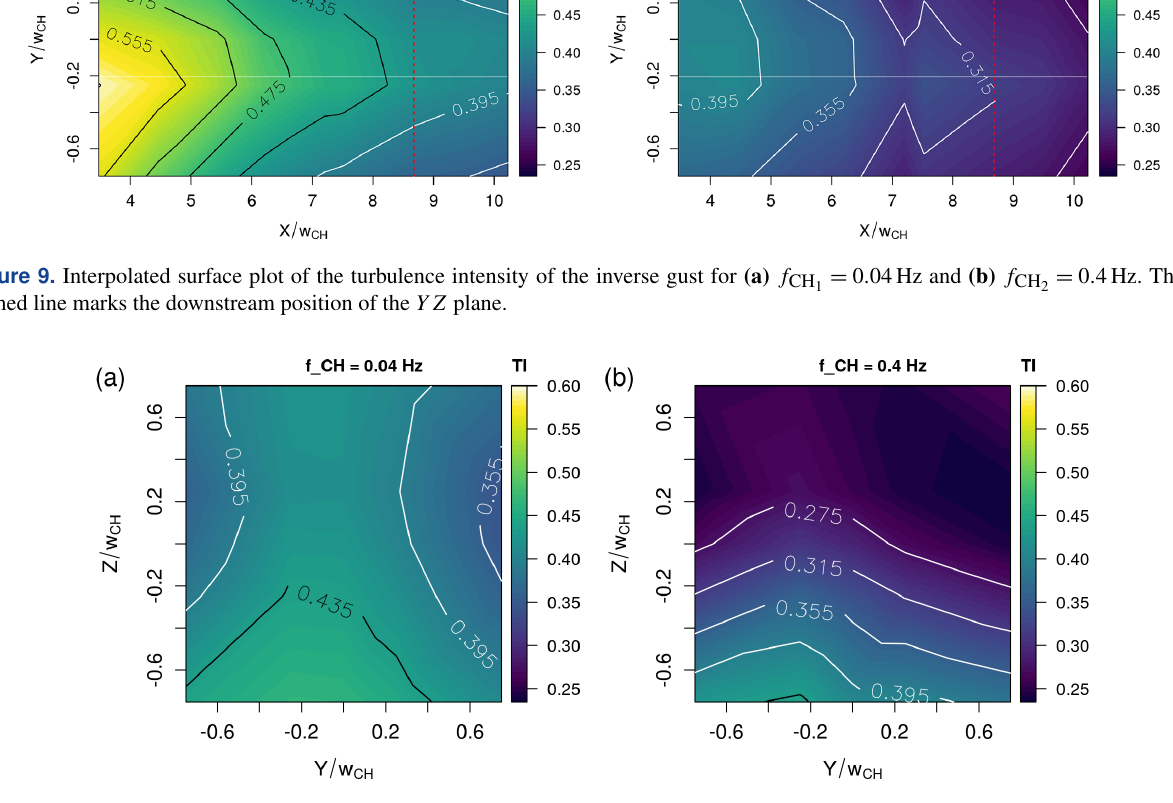
Figure 10. Interpolated surface plot of the turbulence intensity of the inverse gust in the YZ plane 8.675 w CH downstream of the chopper = 0 . 04Hz and (b) f = 0 . blade for (a) f CH CH 2 1